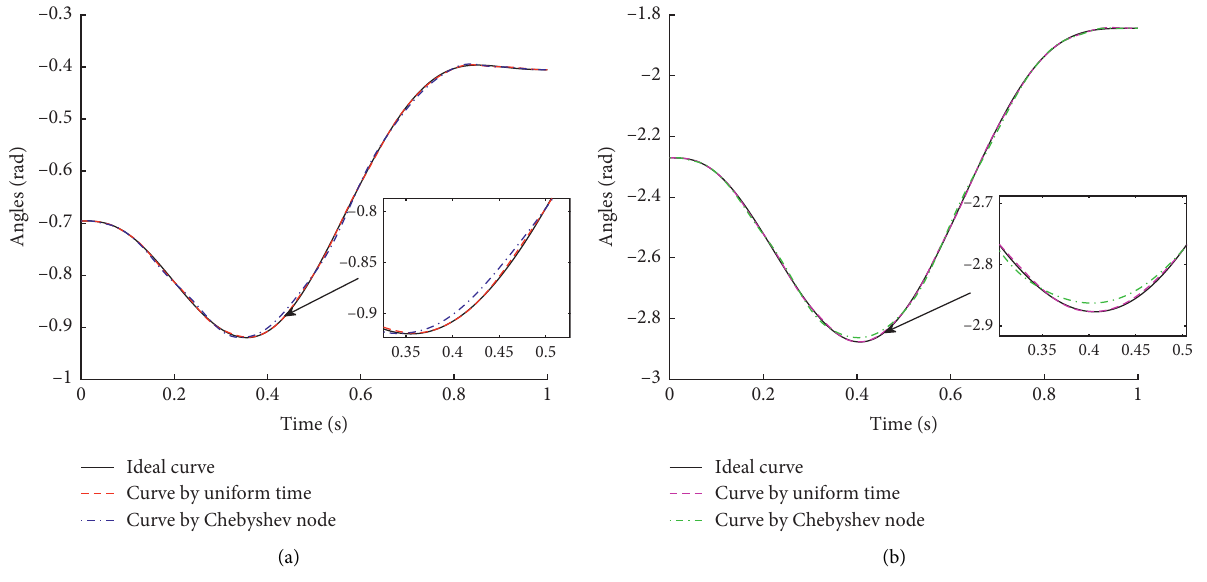
Figure 11: Joint trajectory effect based on temporal divisions. (a) HFE joint trajectory. (b) KFE joint trajectory.